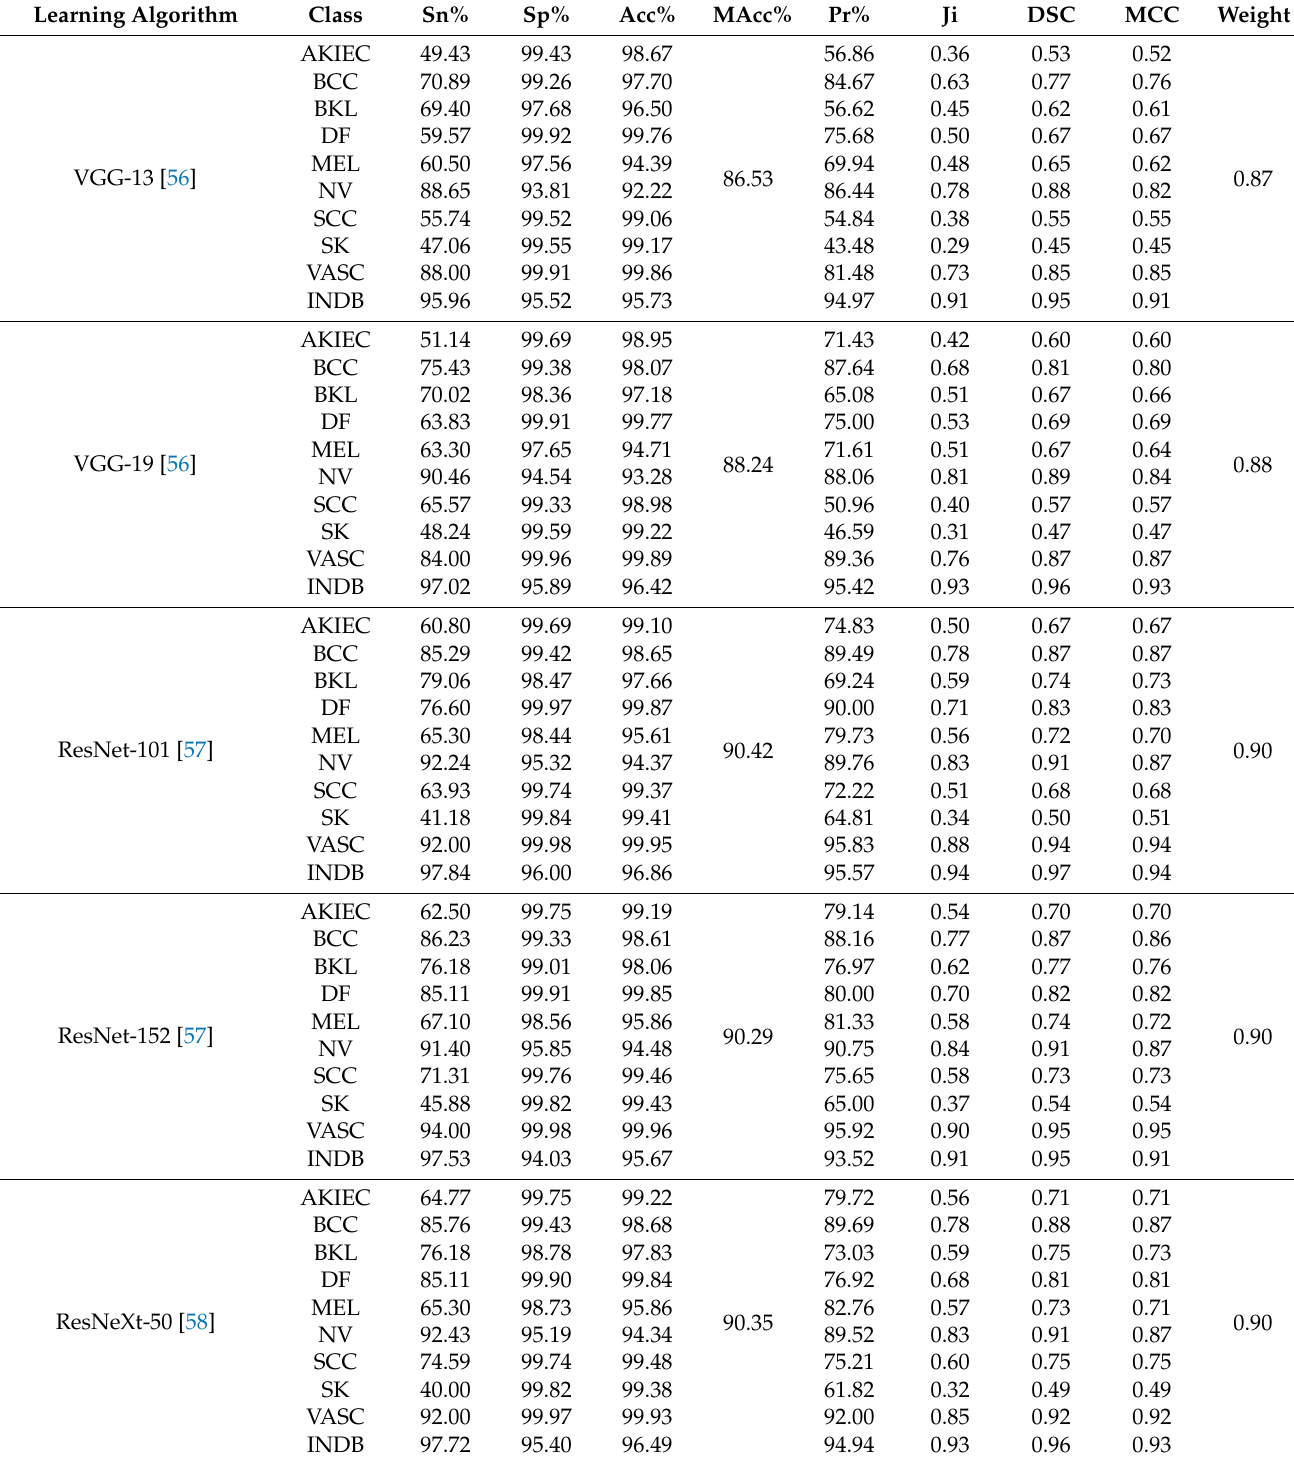
Table 6. Classification of skin lesions into one of the ten multiple